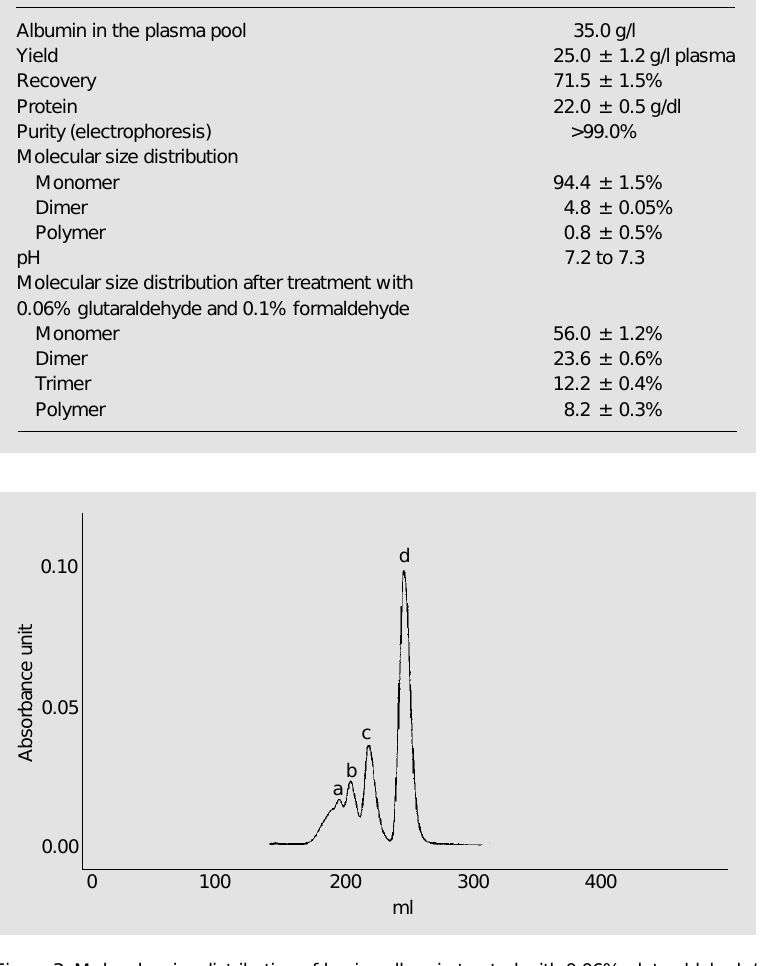
Figure 3. Molecular size distribution of bovine albumin treated with 0.06% glutaraldehyde/ 0.1% formaldehyde, determined by gel filtration using two Superdex 200 HR XK-16/60 columns in series. a , polymer; b , trimer; c , dimer; d , monomer. Absorbance at